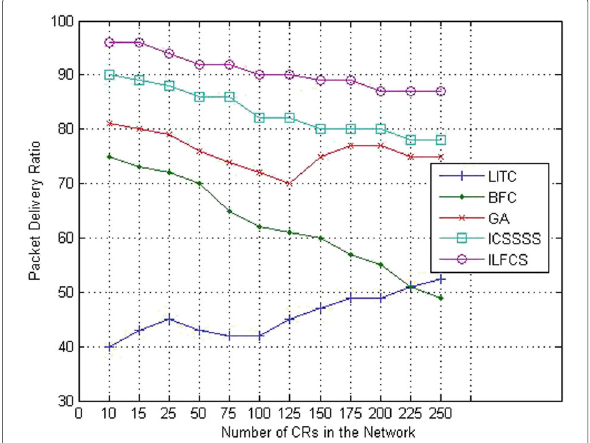
Fig. 10 Spectrum opportunity utilization under different network density. The results of diverse simulation experiments to spectrum opportunity utilization at different numbers of CR nodes for the BFC, LITC, GA, ICSSSS, and the ILFCS are